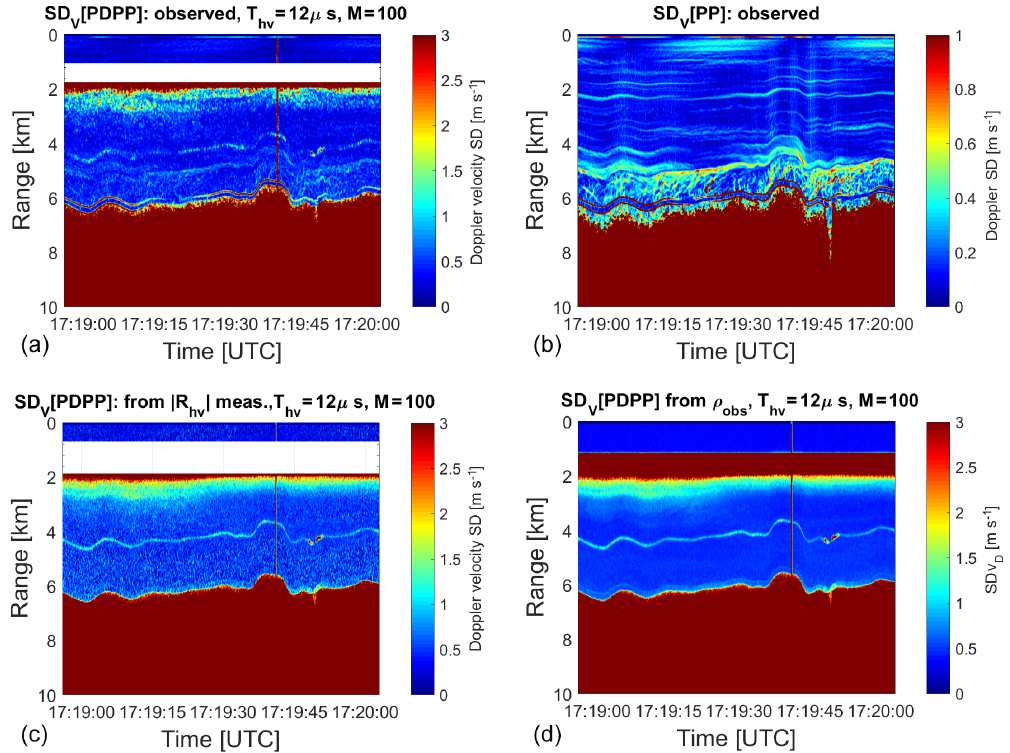
Figure 12. (a, b) Standard deviation of Doppler velocity estimated from the spatial variability of the velocity fields shown in Fig. 11 for the PDPP (a, c) and PP (b, d) technique, respectively (note different scales for the colourbar). Standard deviation of Doppler velocity as derived from Eq. (8) (c) and Eq. (10) (d) .